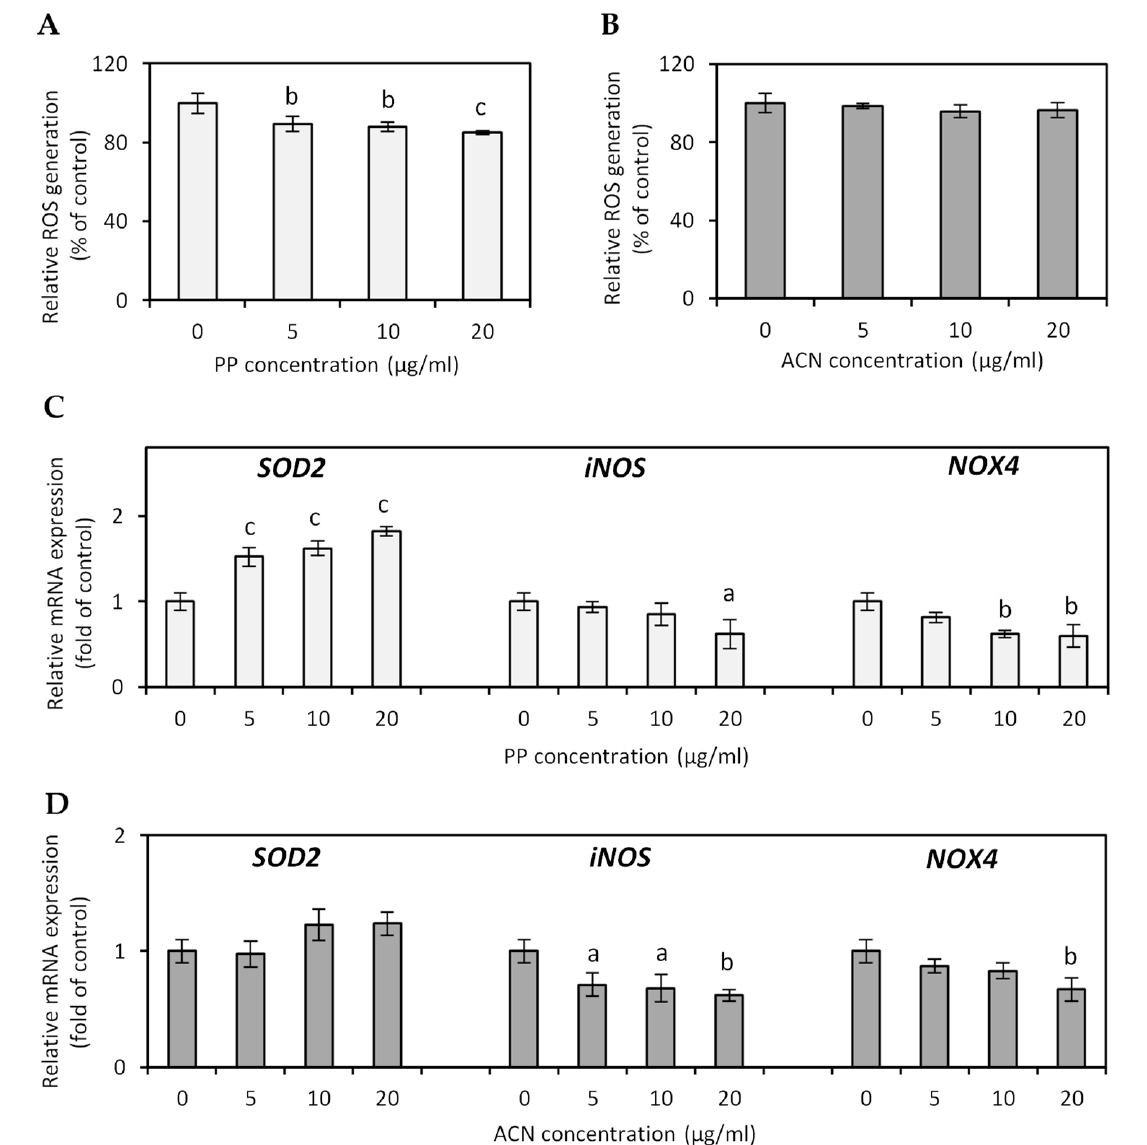
Figure 1. Effect of anthocyanin (ACN) and non-anthocyanin polyphenol (PP) fraction on the intracellular ROS production ( A , B ) and antioxidant and pro-oxidant enzymes mRNA expression ( C , D ) in hypertrophied 3T3-L1 adipocytes. Data are the mean values ± SD ( n = 3). a p < 0.05, b p < 0.01, c p < 0.001.